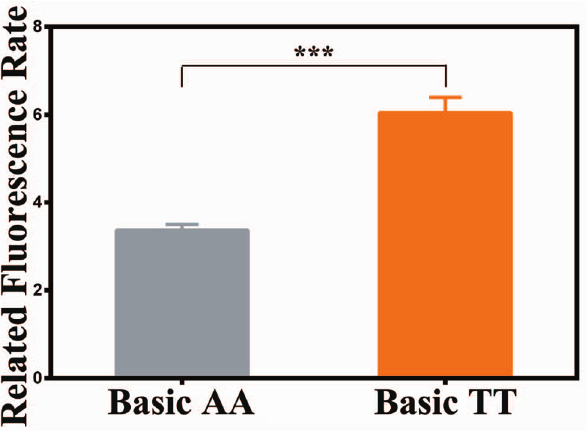
Figure 1. Effect of the rs414171 polymorphism on promoter transcriptional activity. Significantly higher luciferase activities were generated by the pGL3-Basic-T construct as compared to the pGL3- Basic-A construct. (***P ,